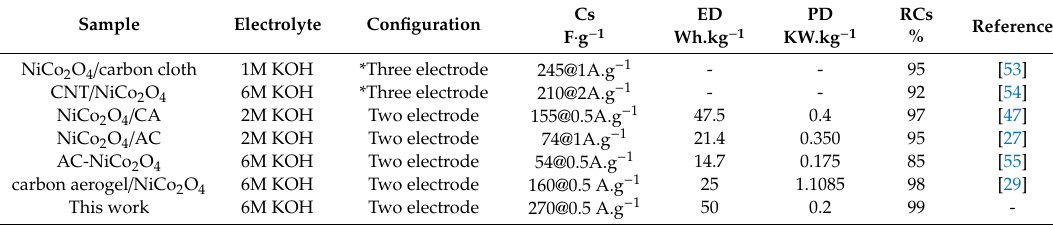
Figure 8. ( a ) Ragone plot, ( b ) stability for all samples at 1A / g over 2000 cycles. Table 4. Electrochemical performance of SCs based on NiCo 2 O 4 /C composite.